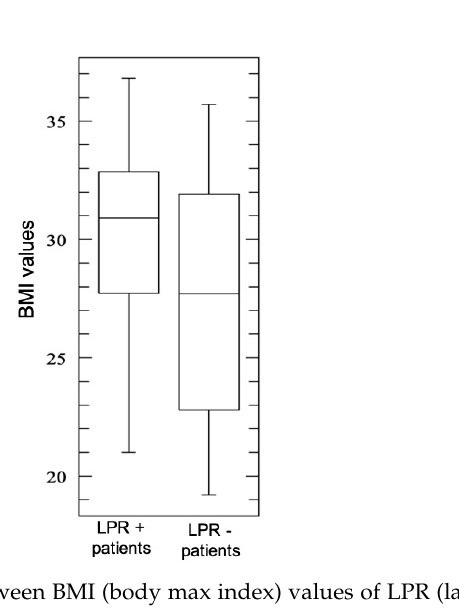
Figure 6. Liner regression scatterplot between BMI and salivary pepsin concentration. Statistically significant correlation ( p = 0.05, R 2 = 0.2).